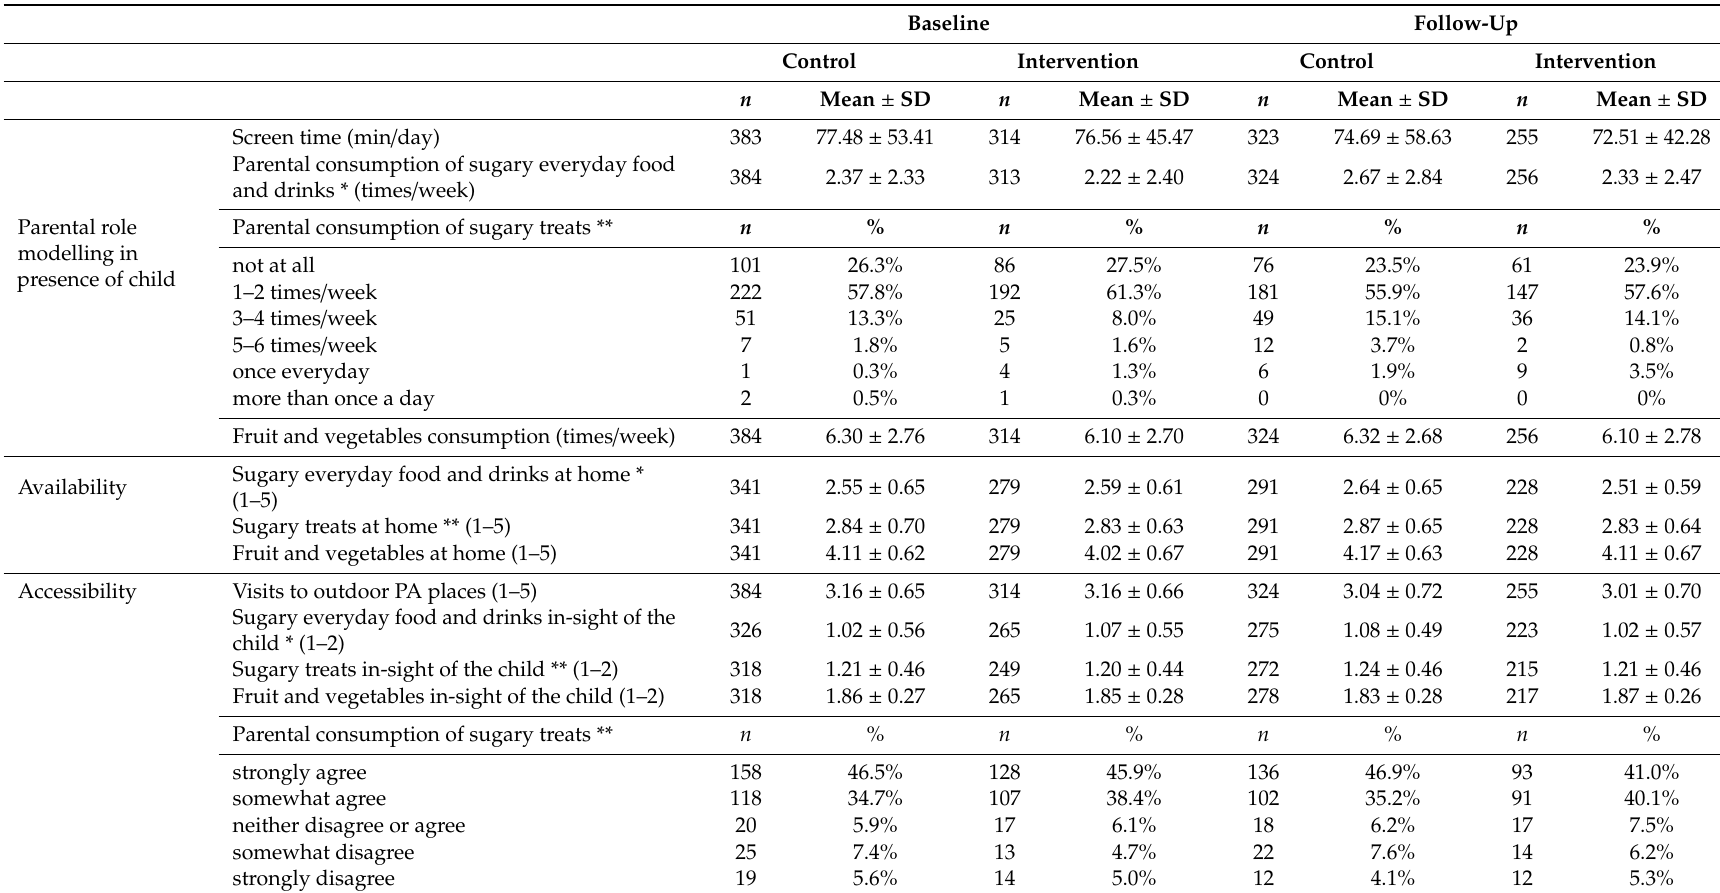
Table 3. Descriptors of outcomes-family